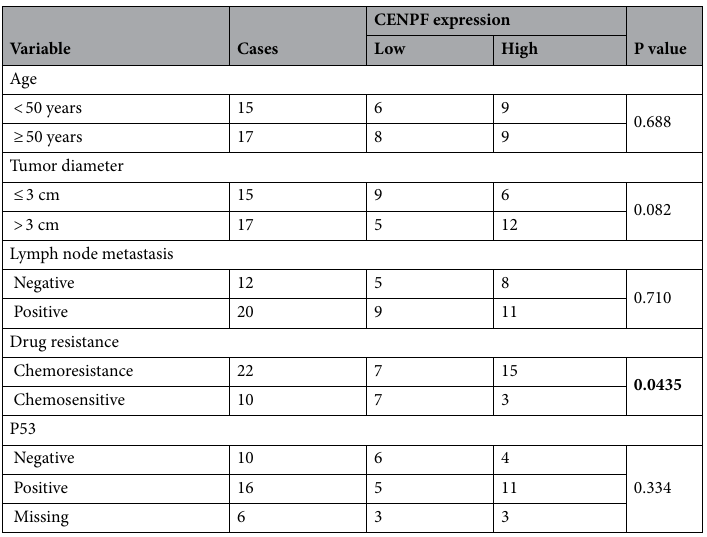
Table 1. Clinicopathological characteristics of 32 TNBC. *The intensity of nuclear staining was scored and graded on a 0–3 scale: 0 (negative); 1 + (weak positive), 2 + (moderate positive) and 3 + (strong positive). This initial score was further classified as low expression (0–1) or high expression (2–3). P value was calculated by statistical analysis of Pearson’s Chi-square test. Significant values are in